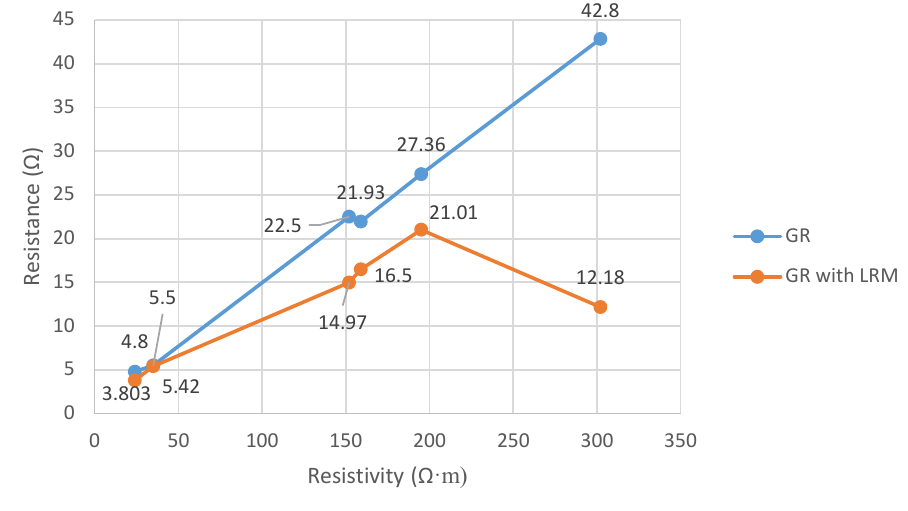
Figure 10. GR vs. 3RP resistivity.